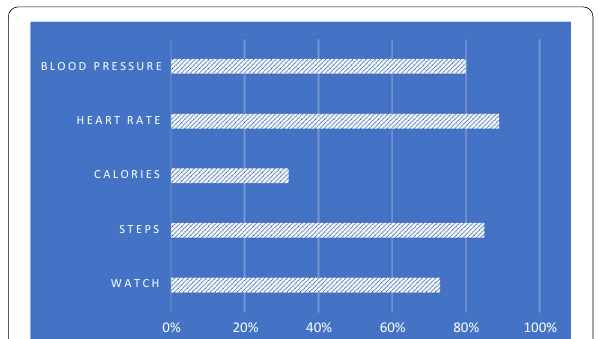
Fig. 1 Self-reported utilisation of the wearable by different functions